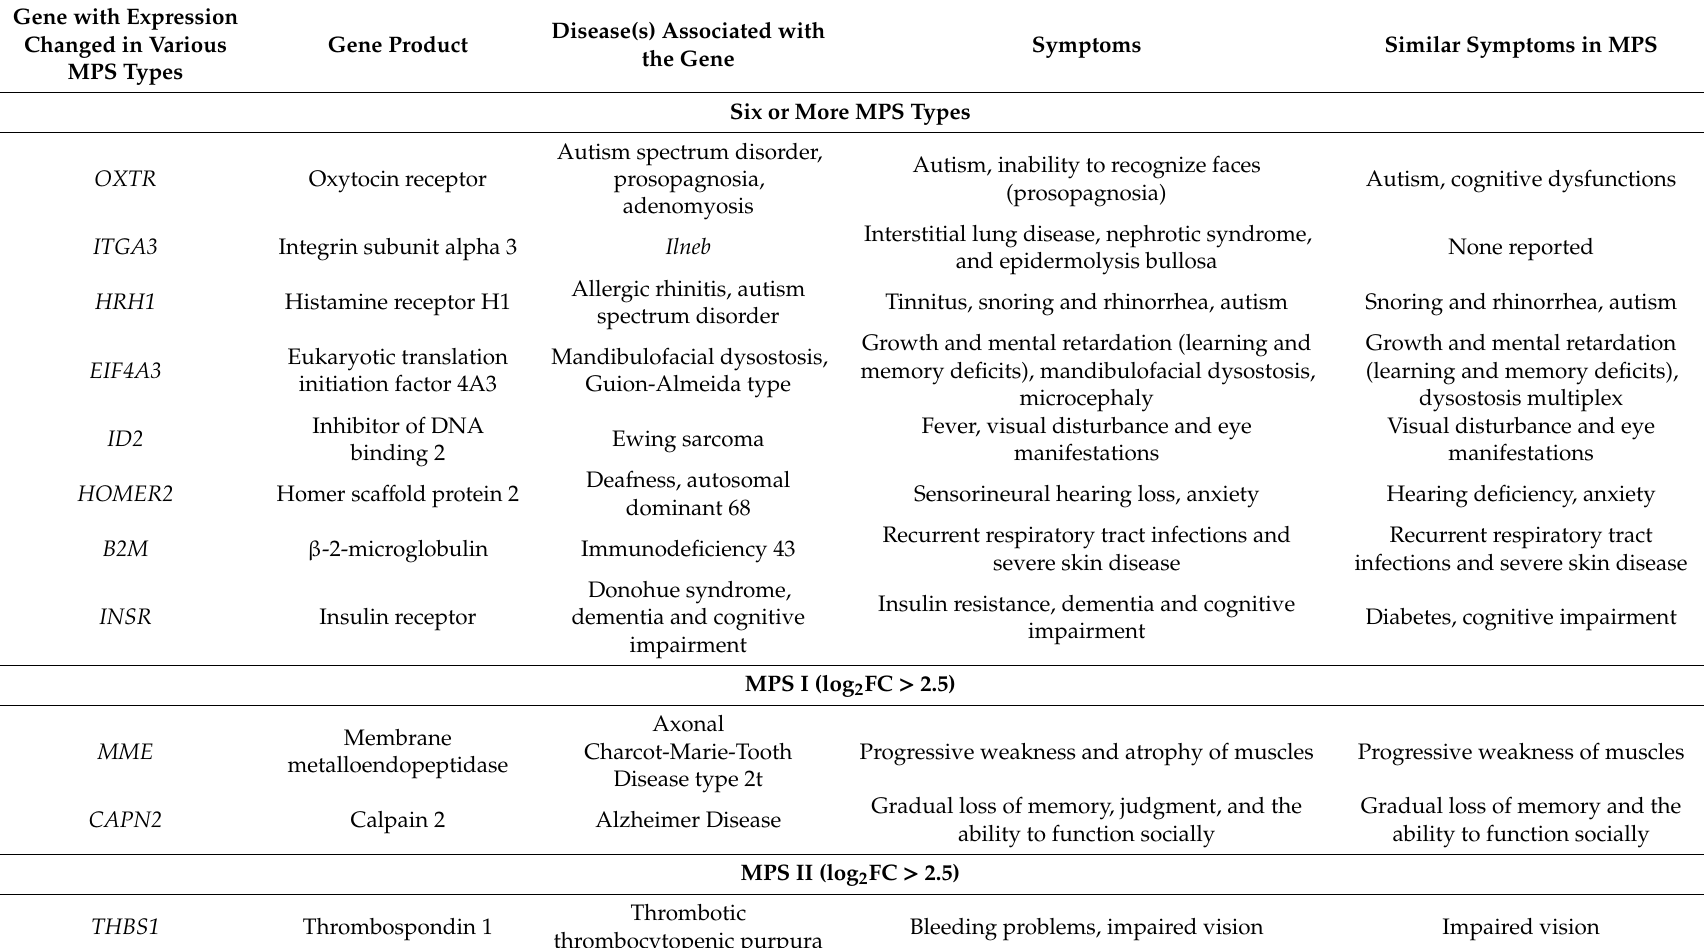
Table 5. Summary of transcriptomic studies of genes related to behavior (term GO:0007610 in the QuickGO database) changed significantly in cell lines derived from patients su ff ering from all types / subtypes of